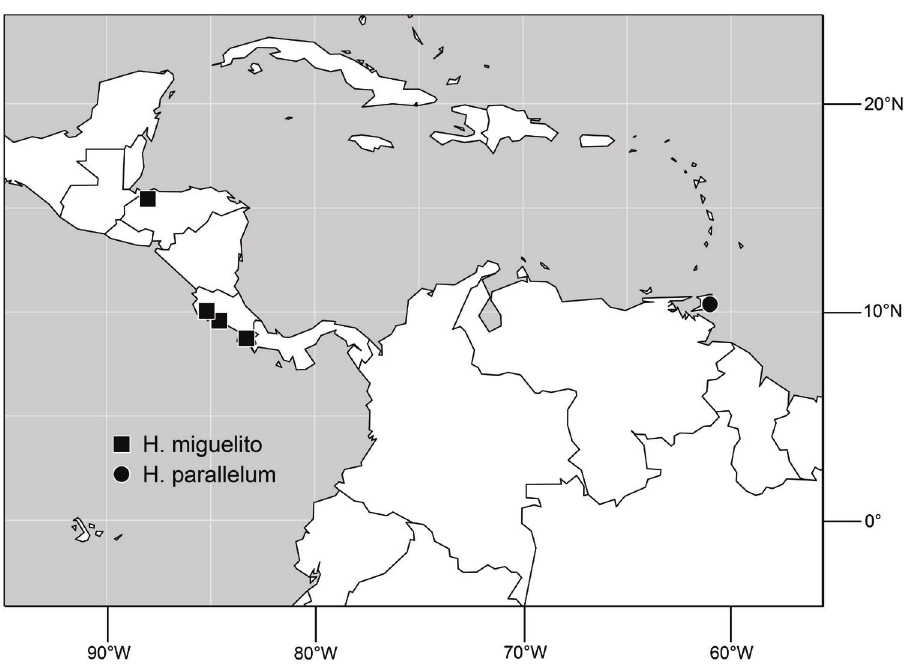
Figure 105. Distribution of Hydrochasma miguelito sp. n. and H. parallelum sp.